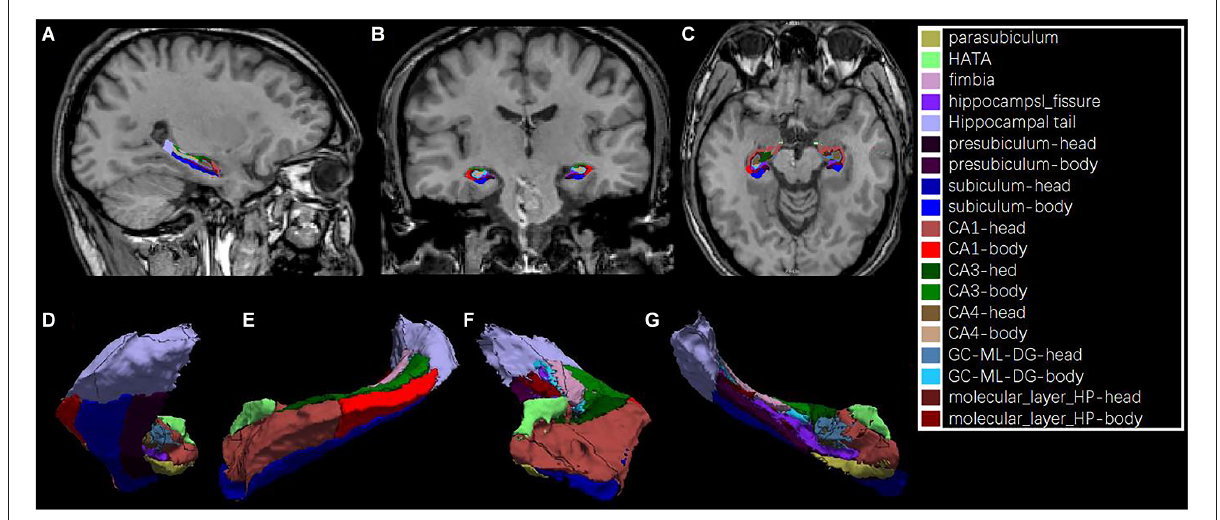
FIGURE1 An example of hippocampal subfield segmentation in healthy Han Chinese individuals living on the plain. Upper row: (A) sagittal, (B) coronal and, (C) axial view of the hippocampus in the brain; Lower row: 3D reconstruction of the hippocampal subfields in (D) dorsal, (E) lateral, (F) frontal and, (G) medial